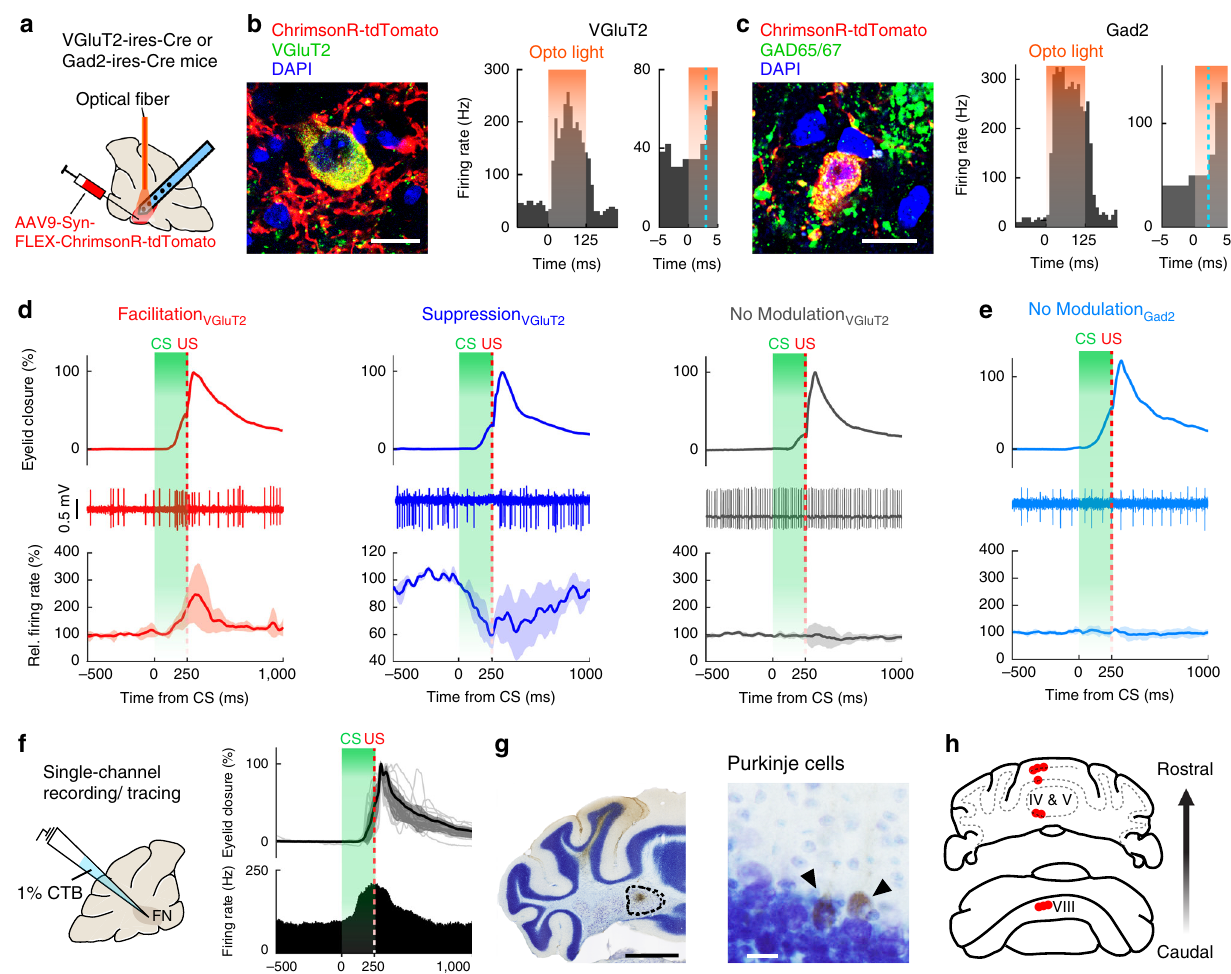
Fig. 2 Task-related modulation in excitatory FN neurons and the identi fi cation of DEC-related vermal regions. a Schematics showing viral injection, optical fi ber implantation and multichannel recording in the FN of the VGluT2-ires-Cre mice ( n = 5) or the Gad2-ires-Cre mice ( n = 8). b , Expression of Cre-dependent ChrimsonR in VGluT2-positive FN neurons (left), showing a short-latency response to 595 nm light (orange shading, right). The blue dashed line indicates the timing at which the fi ring rate exceeds three SDs of the baseline frequency within 20 ms after the light. Scale bar, 10 µ m. c Same as ( b ), but for the Gad2-positive neurons. d Task-related modulation of VGluT2-positive neurons. Neurons are categorized based on their CS-related modulations. Top and middle rows: example eyelid movement and spike traces of individual cells. Bottom row: average fi ring rate of neurons with CS- related facilitation (left, n = 7), suppression (middle, n = 3) and no modulation (right, n = 5); traces are plotted as mean ± s.e.m. e Same as ( d ), but for the Gad2-positive neurons, showing no CS-related modulation ( n = 8). f Left: experimental design for FN neuron recording and CTB tracing by using a single glass capillary. Right: a representative neuron showing CS- and US-related facilitation (overlaying eyelid closure, mean ± SD, n = 21 trials, upper right; PSTH, lower right) during the CS – US interval. g , h Iontophoresis of CTB localized to the recording site ( g , left, scale bar, 1 mm) and retrogradely labeled Purkinje cells ( g , right, scale bar, 20 µ m) in the parasagittal vermis regions ( h ) ( n = 5